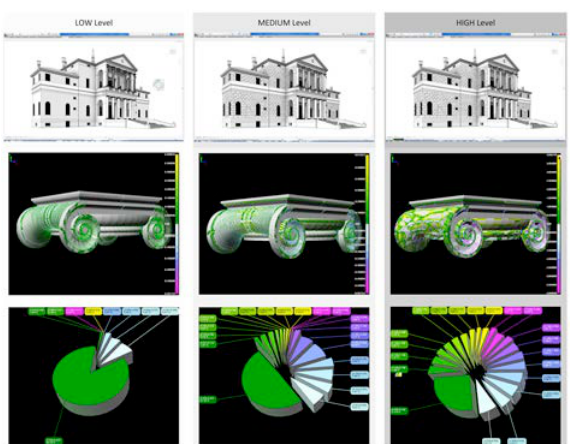
Figure 11. Villa Cornaro: 3D models at different levels of